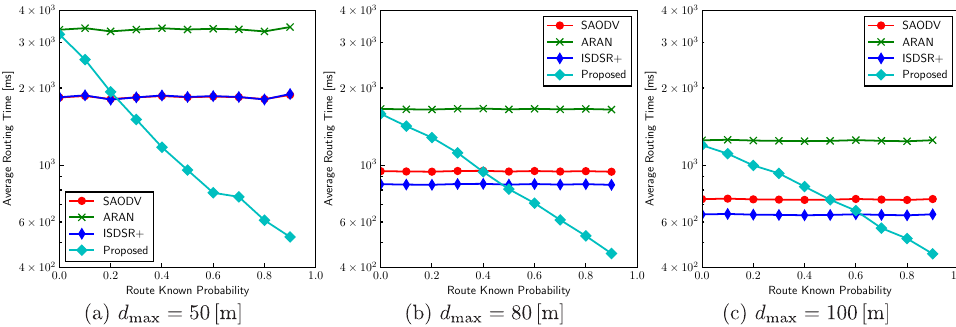
Figure 11. Effects of route known probability on the average routing time (50 relay nodes and p out =